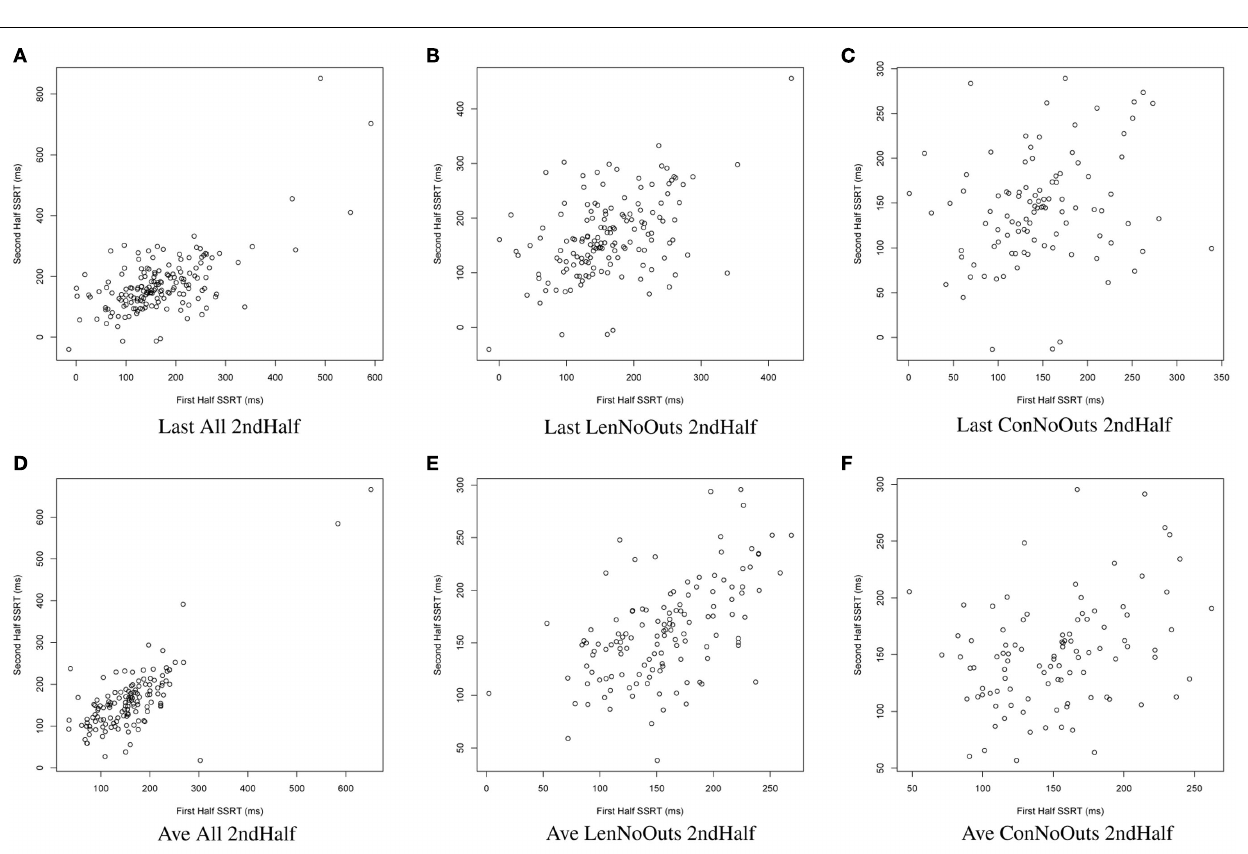
FIGURE 2 | SSRT calculation approaches (A–F): plots of SSRT calculated from two random halves of trials according to the latter six approaches. SSRT values from the first random half of data (x-axis) are plotted against SSRT values from the second random half (y-axis) from a single iteration.The top row includes the last run of all available runs, while the bottom row